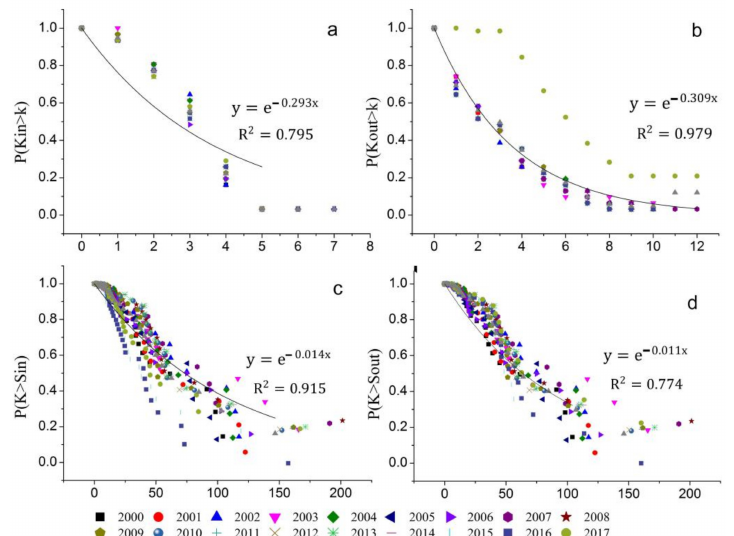
Figure 2. Cumulative distribution of virtual water trade network of China’s major crops in 2000–2017. ( a ) The cumulative distributions of in-node degree. ( b ) The cumulative distributions of out-node degree. ( c ) The cumulative distributions of in-node strength. ( d ) The cumulative distributions of out-node